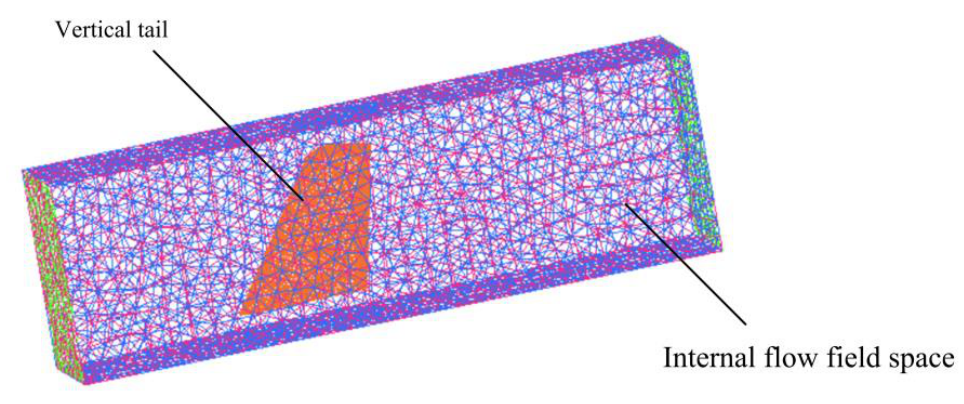
Figure 7. Construction of the internal flow field